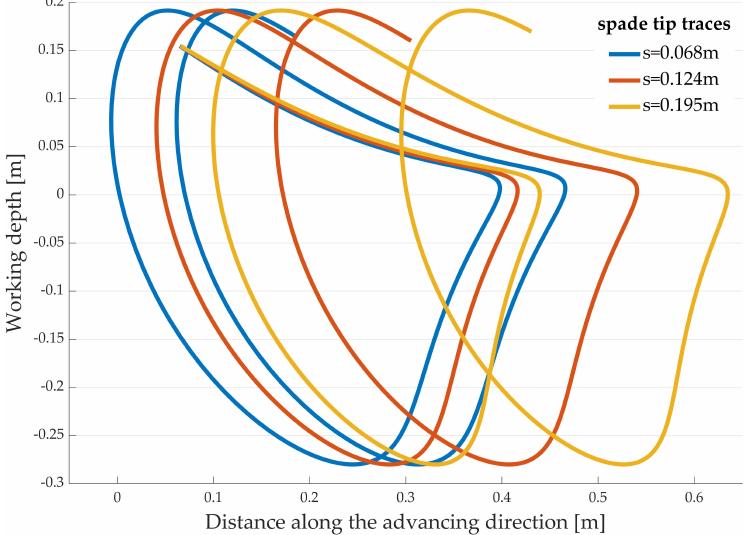
Figure 6. Considering cases IV, V, and VI, with a working depth of 0.28 m, the trace of the spade tip (two-cycle representation for each case) reveals the variation of the soil chip thickness by different working parameters.